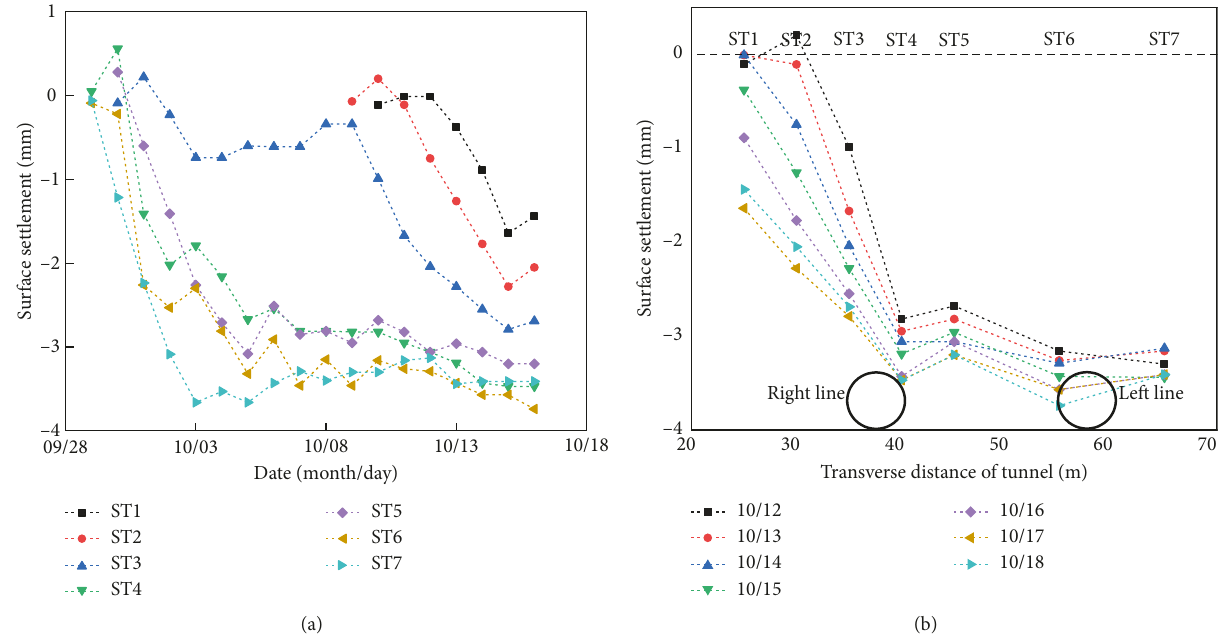
Figure 14: Measured settlement data: surface settlement at (a) each measuring point and (b) different